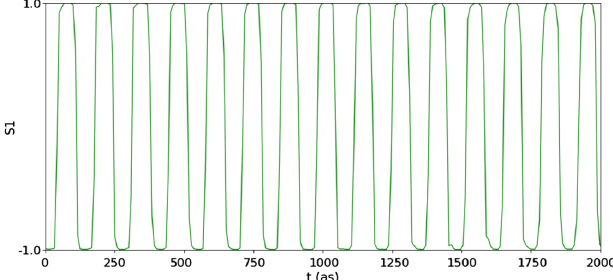
FIG. 3. The on-axis normalized Stokes parameter s 1 as a function of relative time t after 36 undulator-chicane